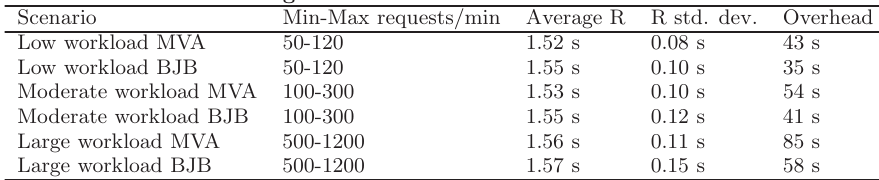
Table 5: Time and configuration results obtained with the RUBiS benchmark Scenario